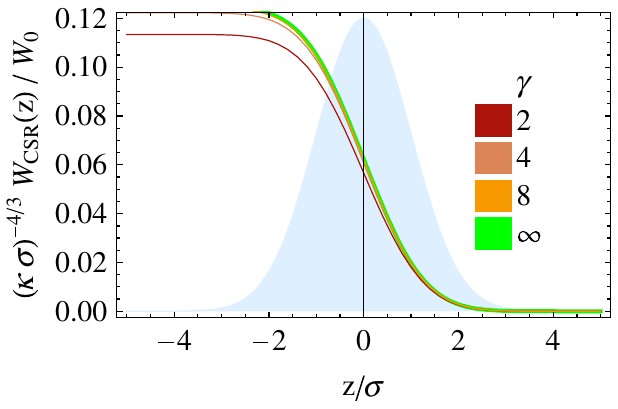
FIG. 4. (Color) The steady-state CSR wake for various relativ- istic (cid:6) due only to particles ahead of the test particle, i.e. negative (cid:9) in Eq. (32), and the second term in the integrand of Eq. (36). A Gaussian bunch is used, with (cid:7)(cid:10) ¼ 3 (cid:5) 10 (cid:1) 5 , and the wake has been scaled by ð (cid:7)(cid:10) Þ (cid:1) 4 = 3 . Compared with Fig. 3 this demonstrates that the contribution to the CSR wake of particles ahead of the test particle is insignificant compared to those behind.